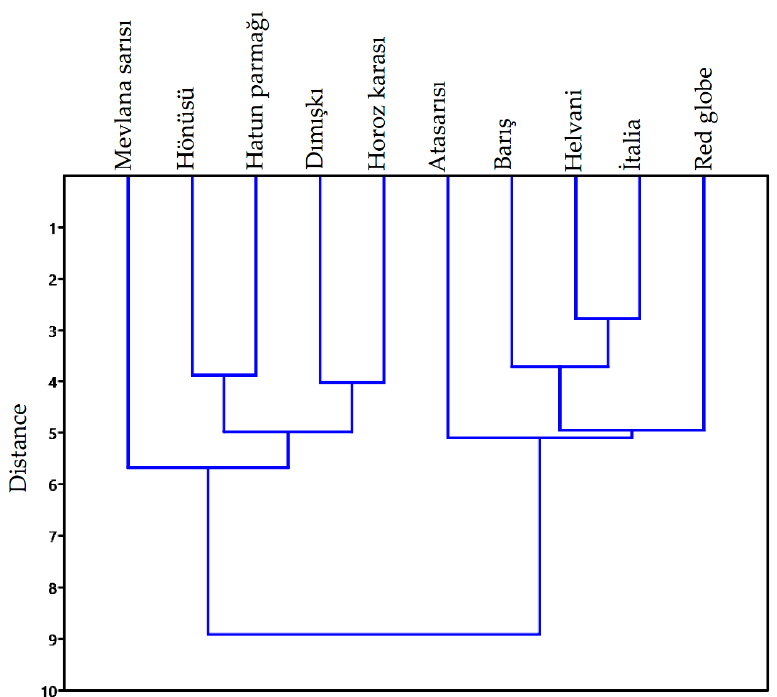
Figure 7. Dendrogram of 10 grape varieties for the discriminant scores obtained from the size and shape data, and principle component scores of the elliptic Fourier analysis using hierarchical cluster analysis (between-group linkage method and Euclidean distance).